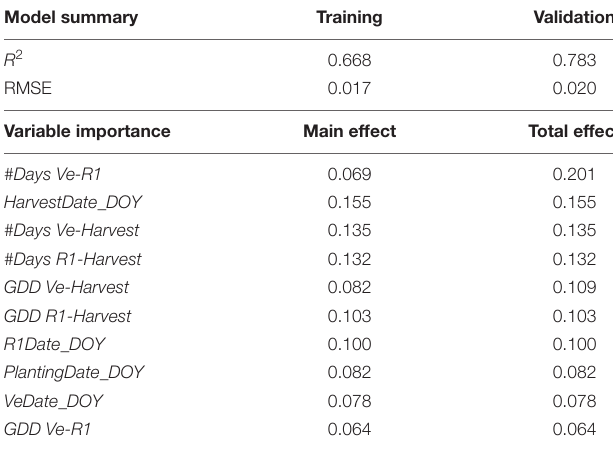
TABLE 4 | Neural Network Analysis model with NTanH(10) summary of training and validation model and variable importance assuming dependent resampled inputs for the prediction of response variable Edamame Harvest Quality Index ( EHQI ) based on phenological (Ve, emergence; R1, first flower) day-of-year (DOY), and thermal functions (GDD, growing degree days) for soybean cultivar R08-4002.